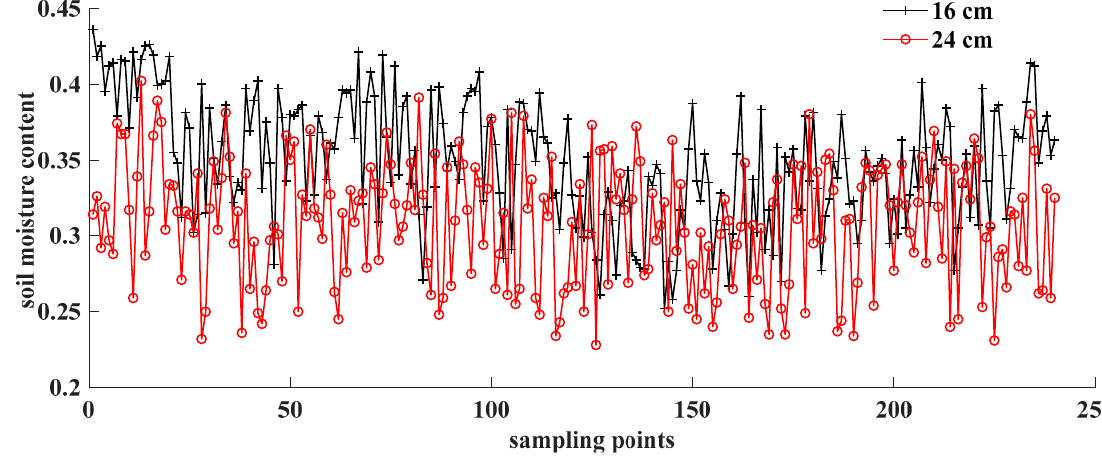
Figure 5. Soil moisture content at tillage depths of 16 cm and 24 cm.